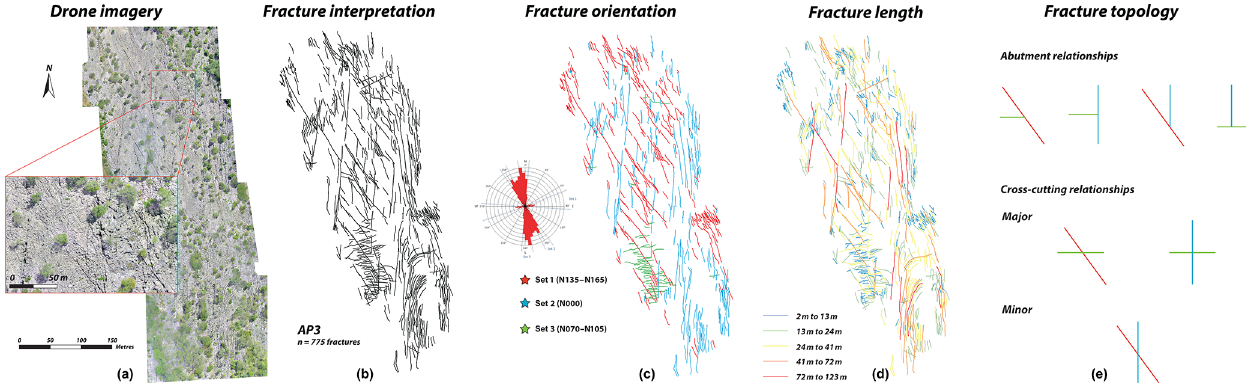
Figure 3. Data acquired in the area of interest from AP3. (a) Orthorectified high-resolution pavement aerial images acquired using a drone; (b) fracture interpretation on orthorectified images; (c) fracture orientation calculated from the north in a GIS-based environment, and the corresponding rose diagram for both outcrops; (d) the length of each fracture trace; and (e) the fracture topology relationship for each pavement observed on fracture network interpretation.